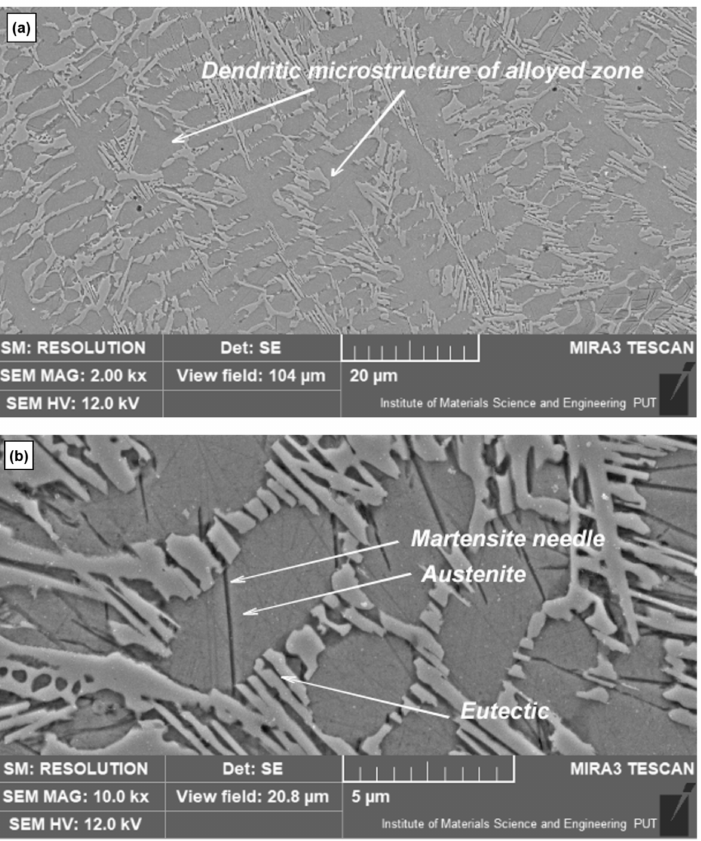
Figure 10. The microstructure of the surface layer after laser implementation of a combination of nickel and chromium; ( a ) SEM micrographs at 2k×; ( b ) SEM micrographs 10k× magnification.